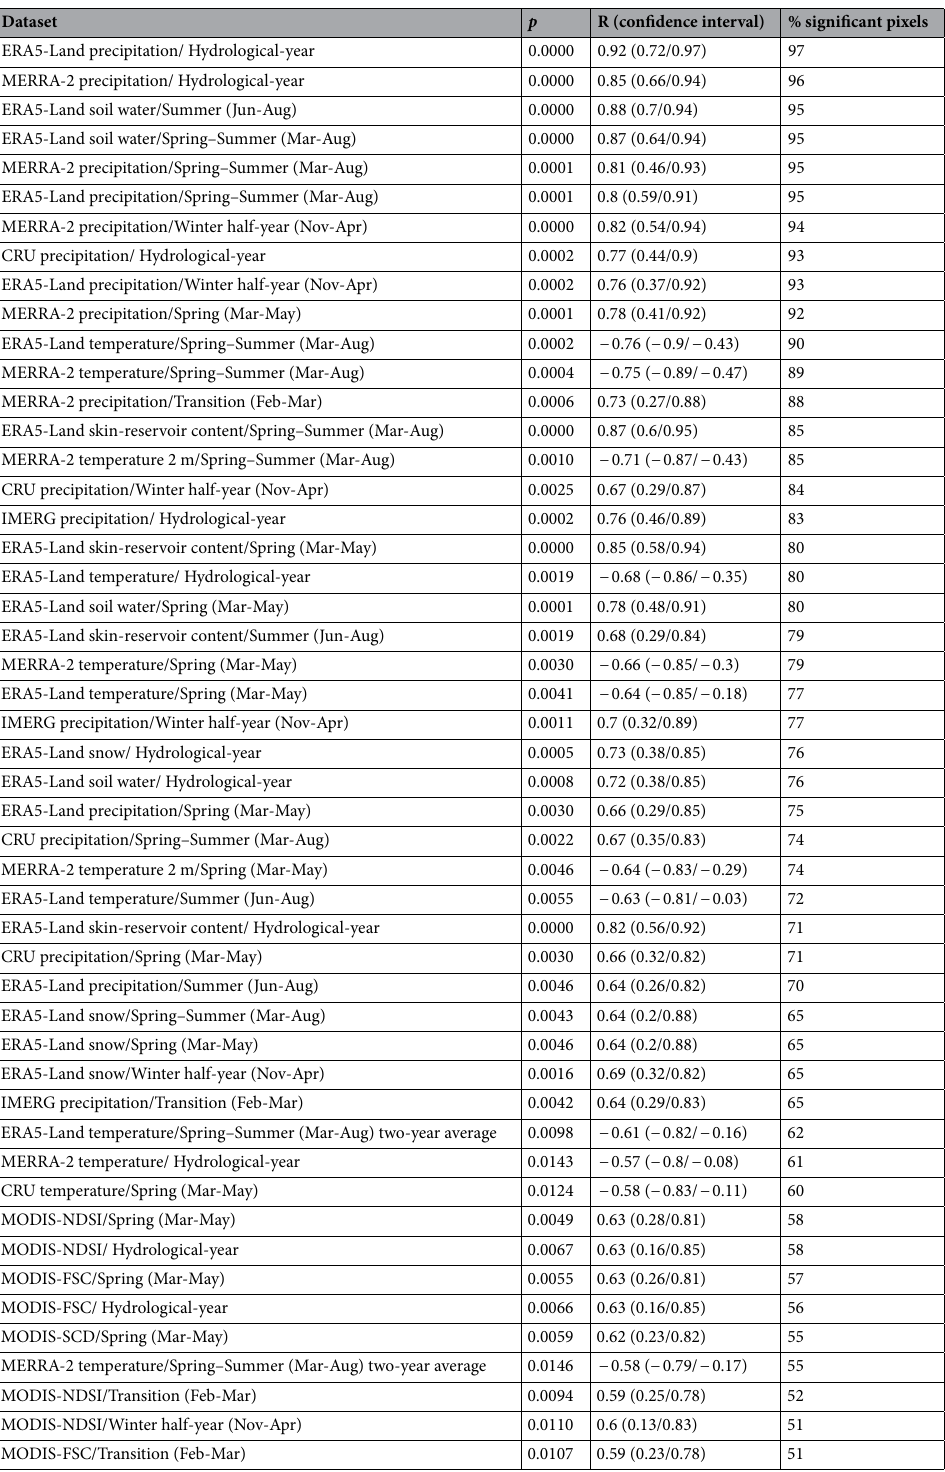
Table 2. Highly suitable variables (significant values controlled at a FDR < 5% and ≥ 50% of analyzed pixels show significant correlation) and evaluation metrics in the Band-e-Amir study region. Descending order based on percentage of significant